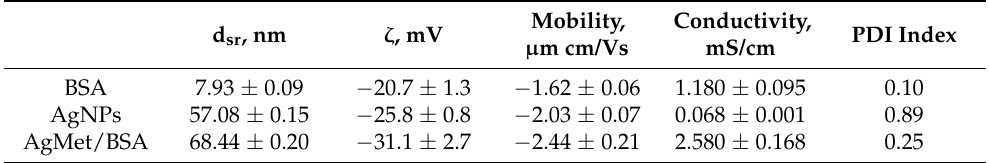
Table 1. The hydrodynamic diameter (d), zeta potential ( ζ ), mobility, and conductivity obtained by DLS and zeta potential measurements. In the final concentration, the solution contained 2 × 10 − 10 M AgMet and 5 × 10 − 6 M BSA in 10mM phosphate buffer, pH 7.4.